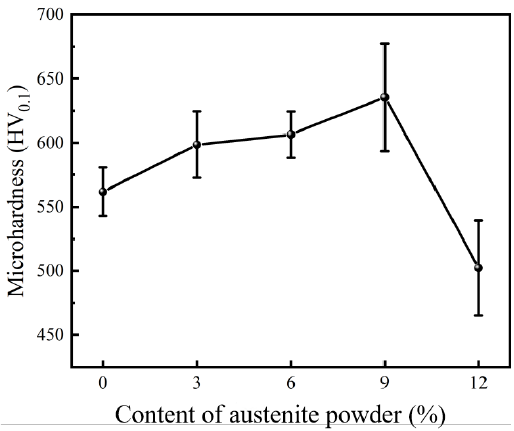
Figure 8. Microhardness of the coatings.